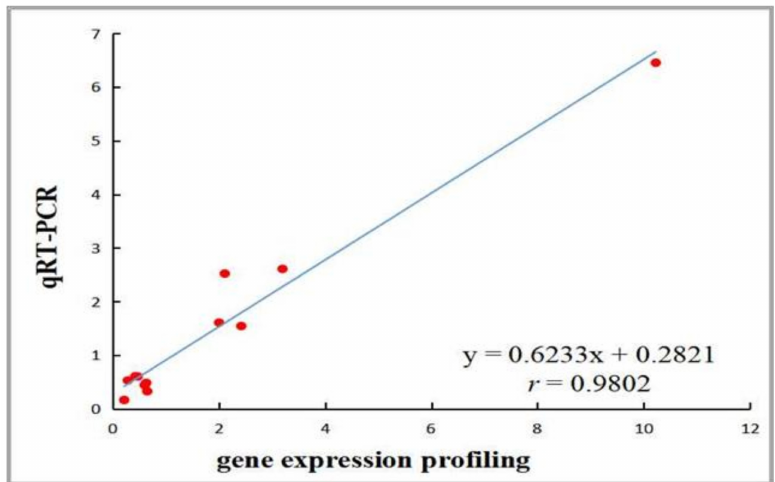
Figure 4. Correlation analysis of gene expression profiling and qRT-PCR results. The correlation between gene expression profiling and qRT-PCR data was analyzed by Spearman rank correlation in the ovariectomized and sham-operated groups. A high correlation coefficient ( r = 0.9802, p < 0.05) was detected, which indicates that the gene expression profiling data are reliable.